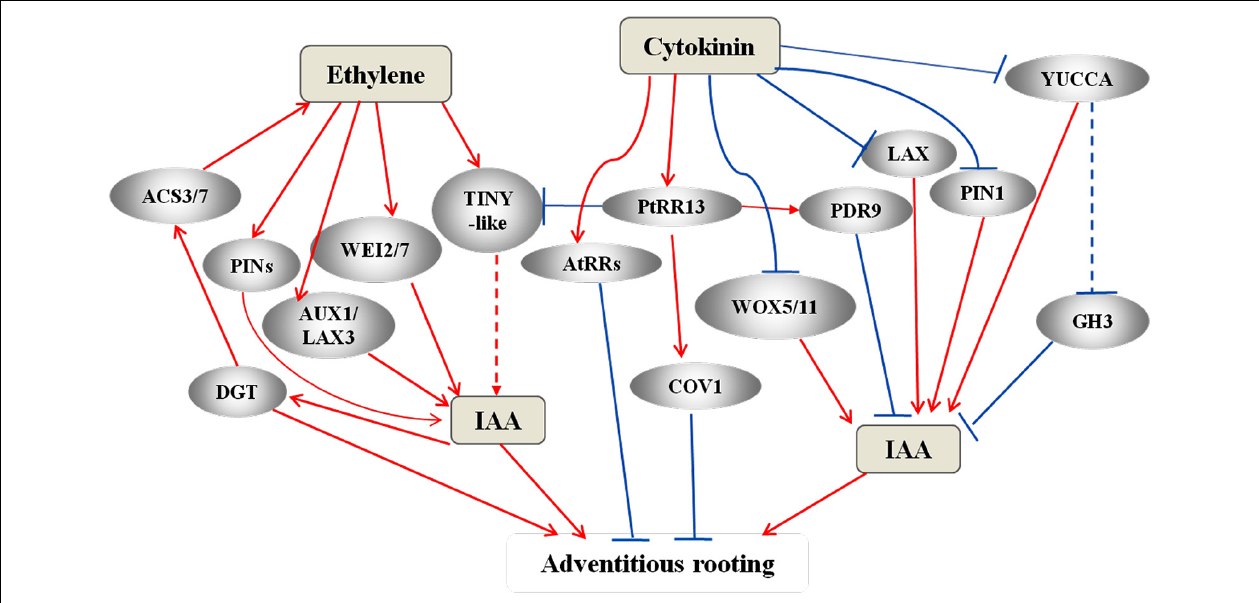
FIGURE 4 | A complex network of IAA, ethylene, and cytokinin that has been proposed to regulate AR formation. In the AR models of Arabidopsis and flooded tomato, auxin triggers ethylene synthesis through the expression of DIAGEOTROPICA ( DGT ) and ACC synthesis genes ACS3 and ACS7 (Stepanova et al., 2005; Negi et al., 2008; Vidoz et al., 2010). Ethylene promote IAA synthesis via activating of WEI2 and WEI7 (Ruzicka et al., 2007; Stepanova et al., 2007; Swarup et al., 2007) and promotes polar auxin transport via activating PINs and AUX1 and LAX3 (Swarup et al., 2007; Negi et al., 2008, 2010). Cytokinin signaling activates RRs to repress AR in Arabidopsis (Argyros et al., 2008). In the AR model of poplar cuttings, the active PtRR13 repress AR formation by promoting the expression of COV1 and PDR9 and also by inhibiting the expression of TINY-like transcription factors (Ramirez-Carvajal et al., 2009). TINY is an activator of ethylene signaling (Sun et al., 2008) and a possible intersection point between ethylene and cytokinin signaling. Cytokinin also regulates auxin homeostasis and accumulation by negatively affecting the auxin carriers PIN1 and LAX3, and the WOX and YUCCA genes, thereby regulating adventitious rooting through these pathways, as well. Red arrows represent positive regulation, and blue bars represent negative regulation. The dotted lines or arrows represent the pathways need further identified.